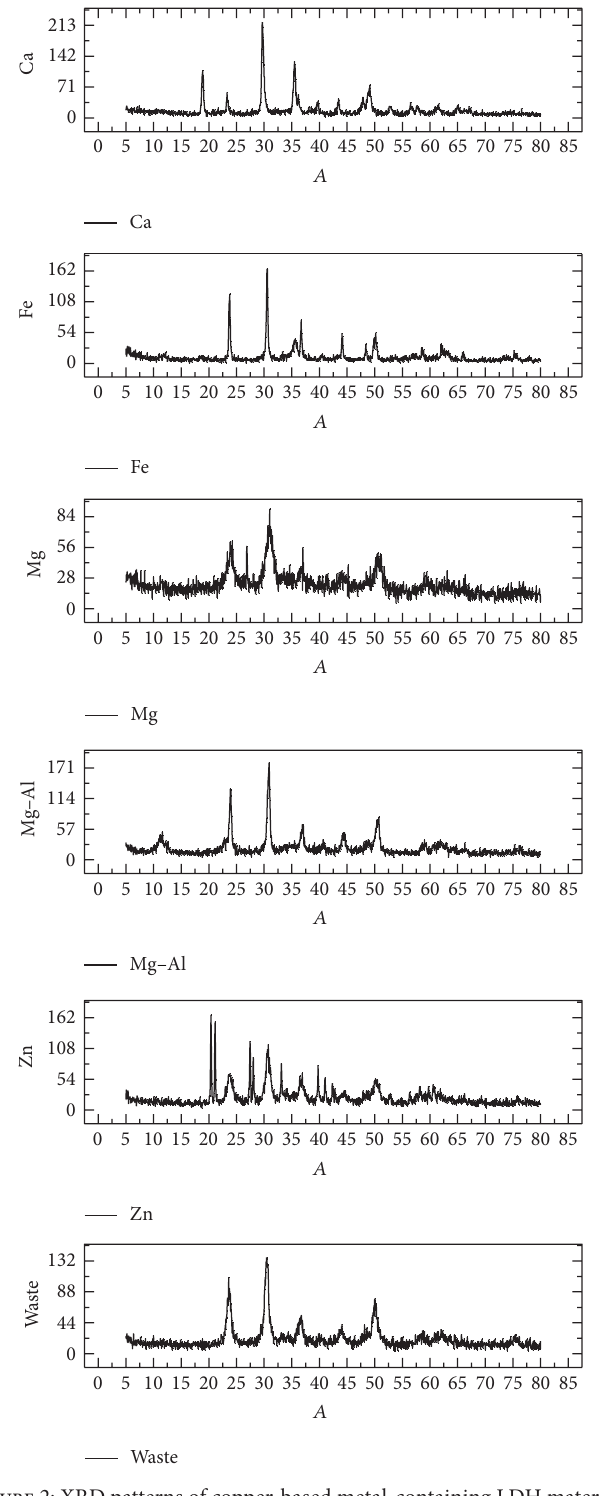
Figure 2: XRD patterns of copper-based metal-containing LDH